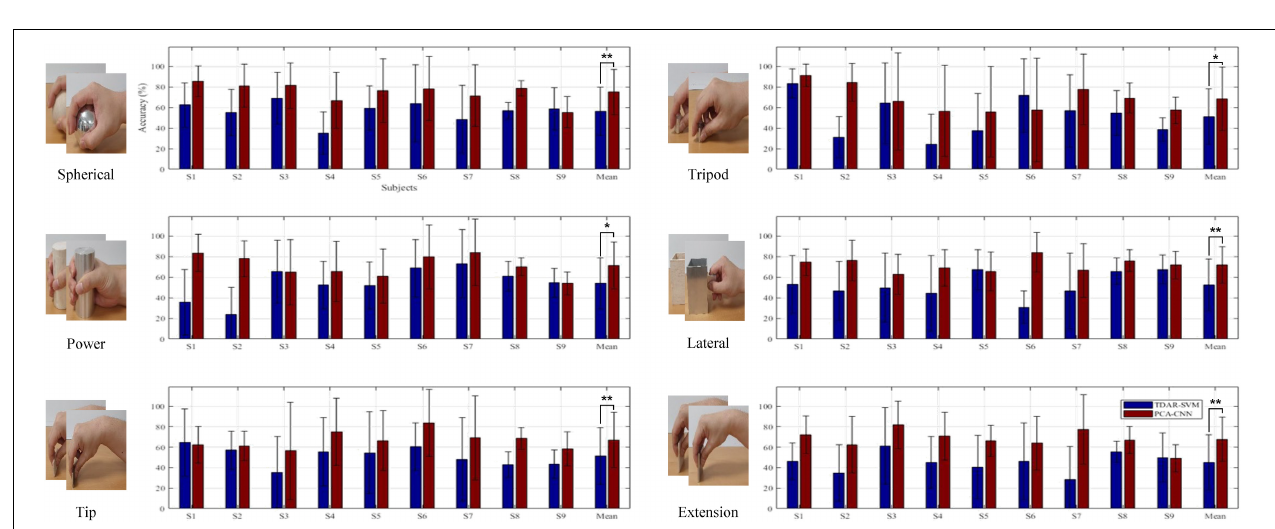
FIGURE 7 | Averaged results of classifying different weights (light/heavy) within same grasping types (spherical, tripod, power, lateral, tip, and extension grip). S in x -axis indicates each subject (* and ** means p -value < 0.05 and 0.01,